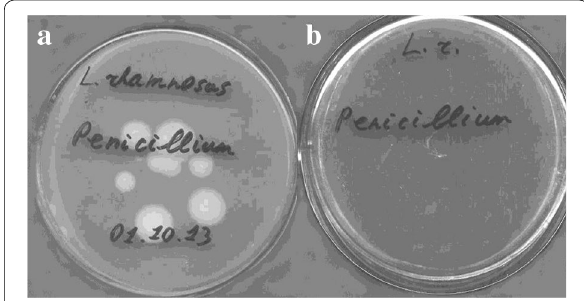
Fig. 1 Antifungal activity of L. rhamnosus MDC 9661 strain. A after 24 h of cultivation, B after 48 h of cultivation. For details see “Materials and methods”